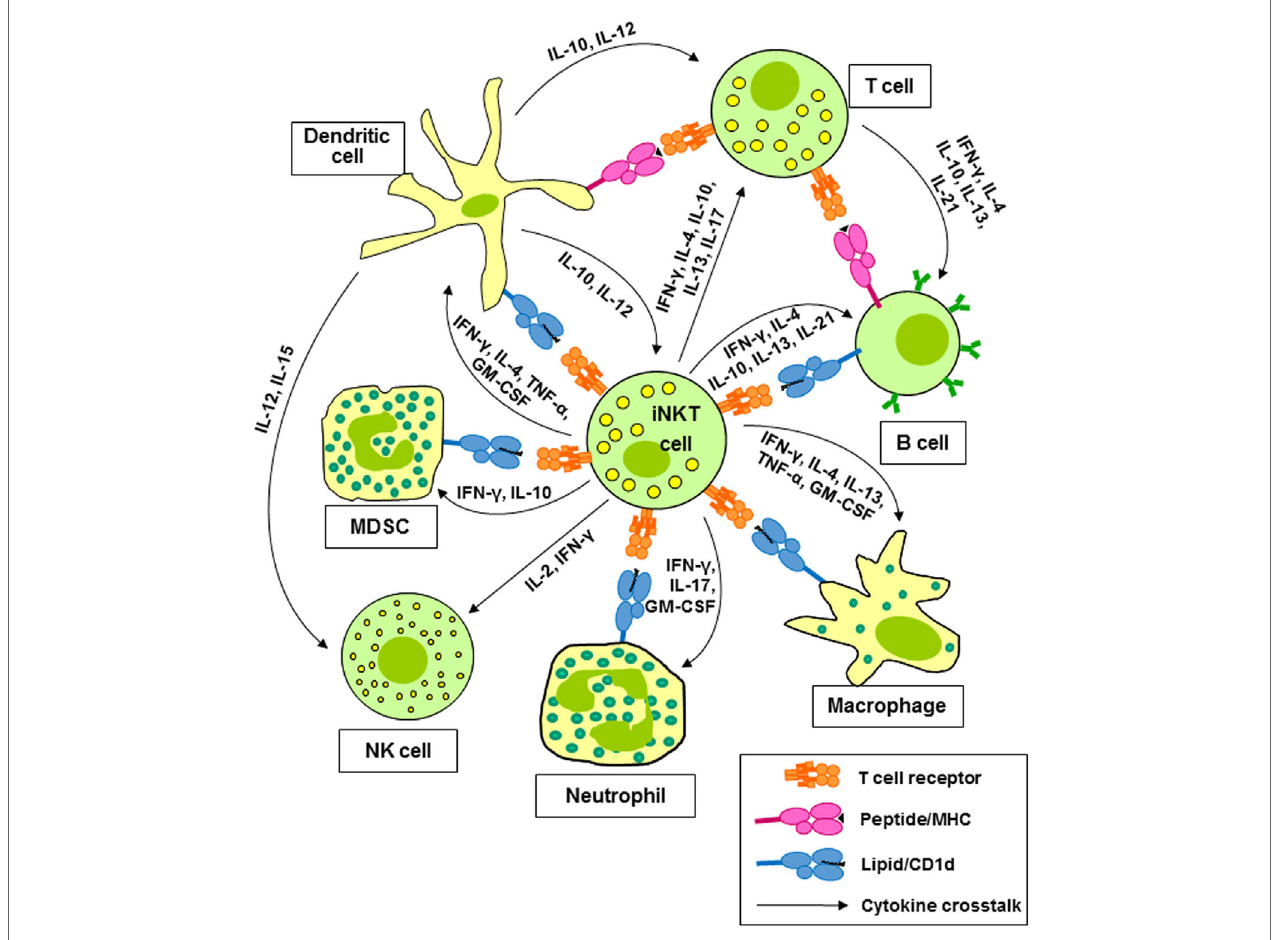
FigURe 1 | Invariant natural killer T (iNKT) cells activate and regulate multiple cells of the innate and adaptive immune systems. Cytokines released by iNKT cells contribute to the activation and polarization of CD4 + and CD8 + T cells and natural killer (NK) cells. Cytokines and CD1d-dependent interactions between iNKT cells and dendritic cells (DCs), macrophages, neutrophils, and myeloid-derived suppressor cells (MDSC) lead to the activation and regulation of the effector activities of these